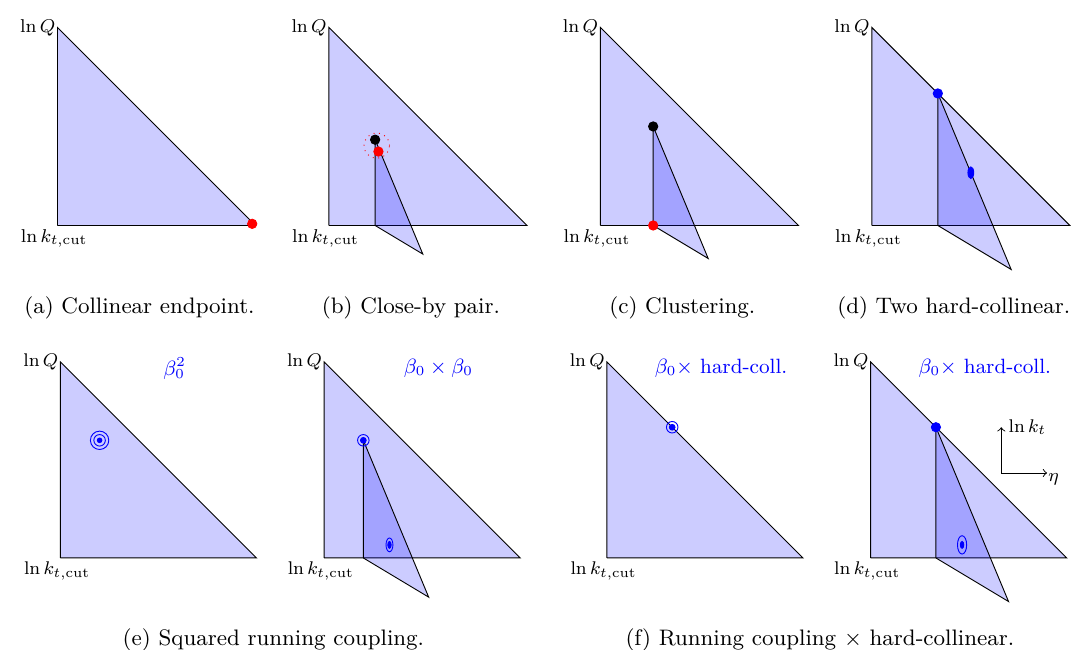
Figure 2 . Lund representation of the NNDL configurations that are identical in e + e − and pp collisions. Black dots indicate emissions which contribute a factor α contribute a factor α , and red dots emissions which contribute as α s L are represented by open